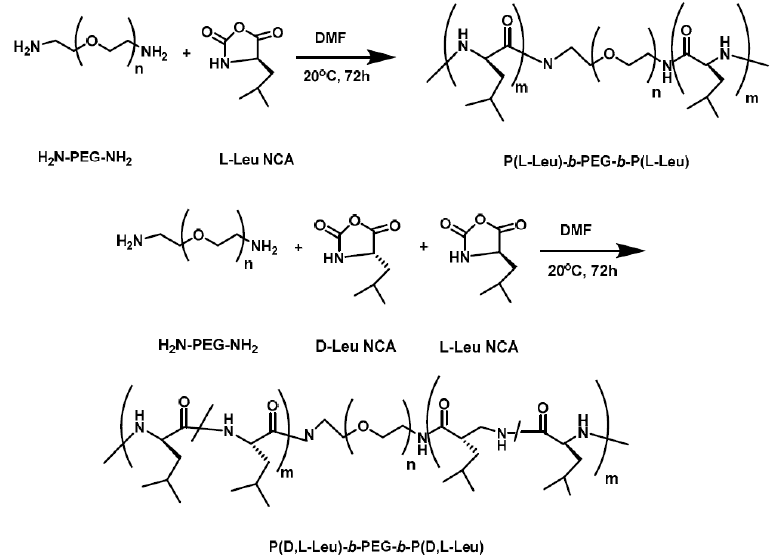
Figure 2. Synthesic approach for the synthesis of P( L –Leu)– b –PEG– b –P( L –Leu) and P( D , L –Leu)- b -